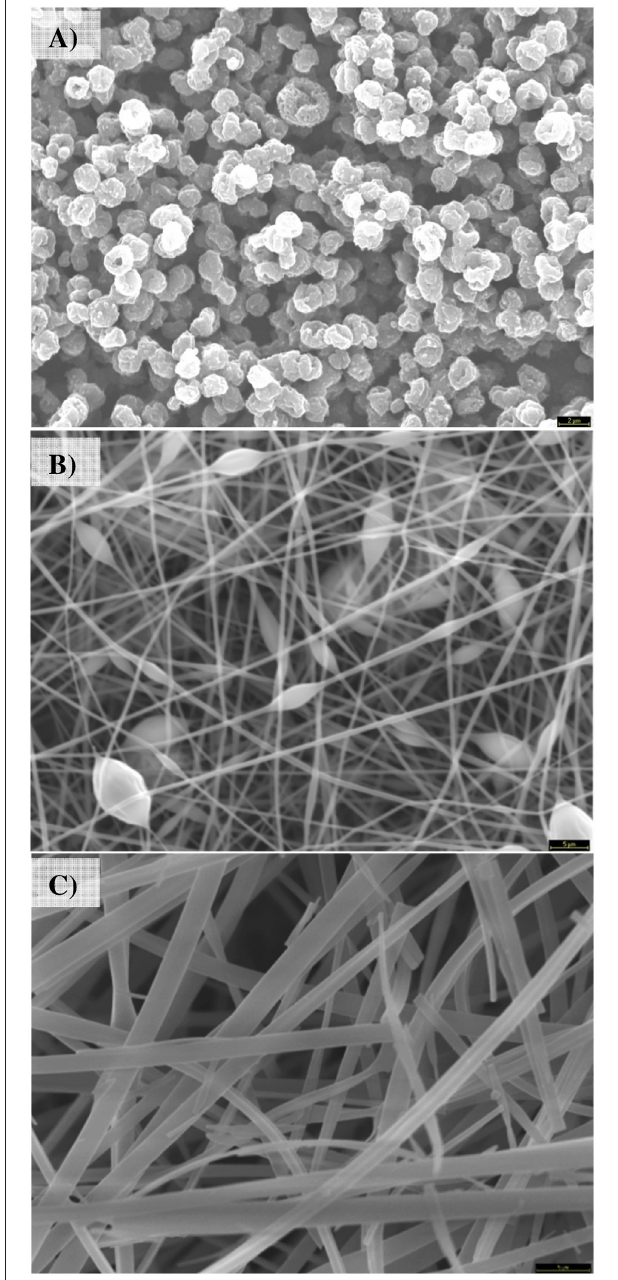
FIGURE 1 | SEM images of lignin (A) spheres (scale bar: 2 µ m); (B) beaded fibers (scale bar: 5 µ m); and (C) linear fibers (scale bar: 5 µ m).